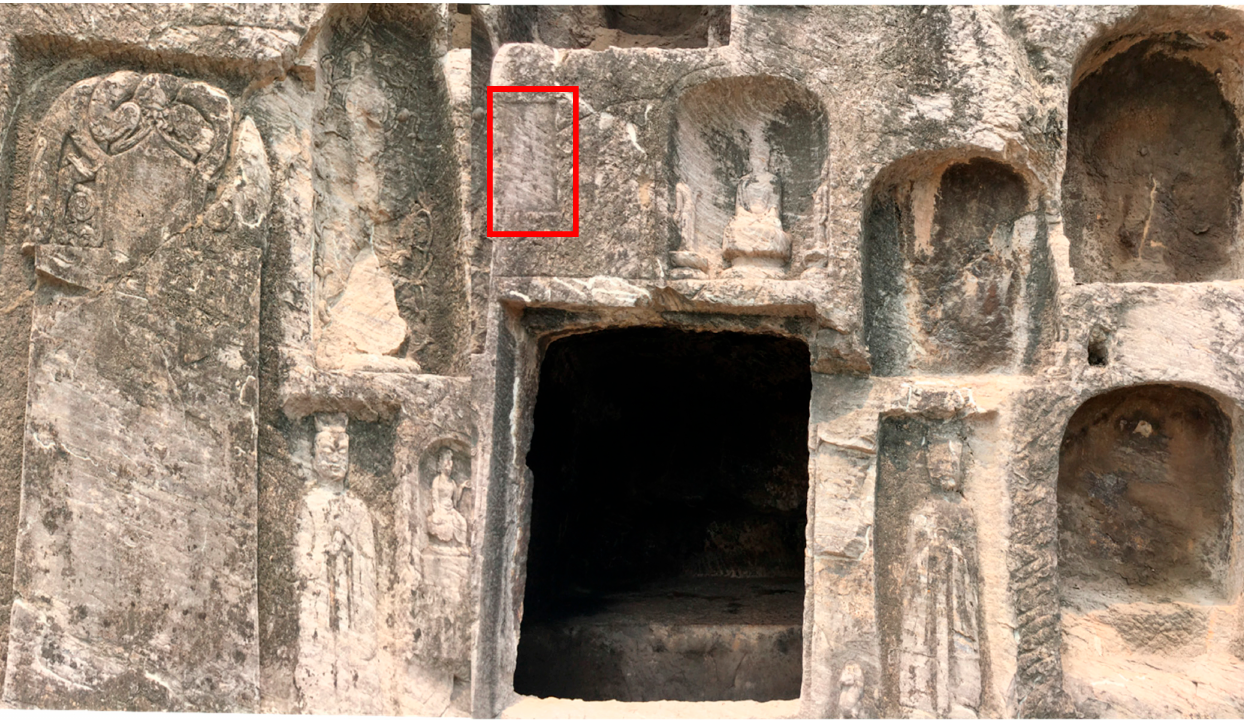
Figure 4. Cave 1850 of Lady Zhang, with the burial inscription marked in red. Image by the author, 2019.